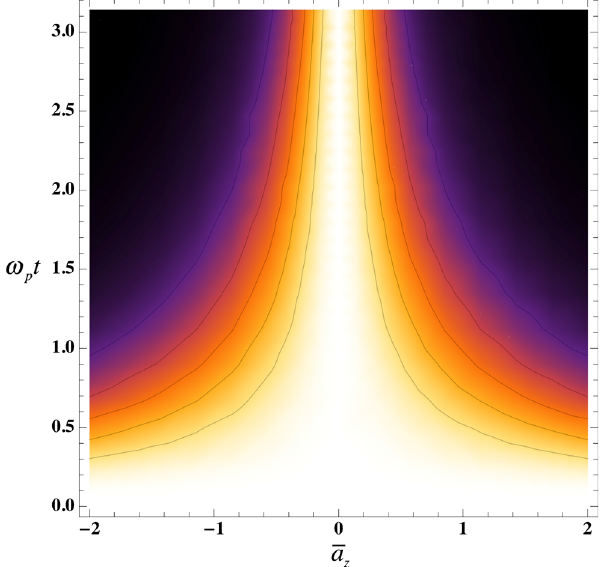
, and x ¼ ω t p p